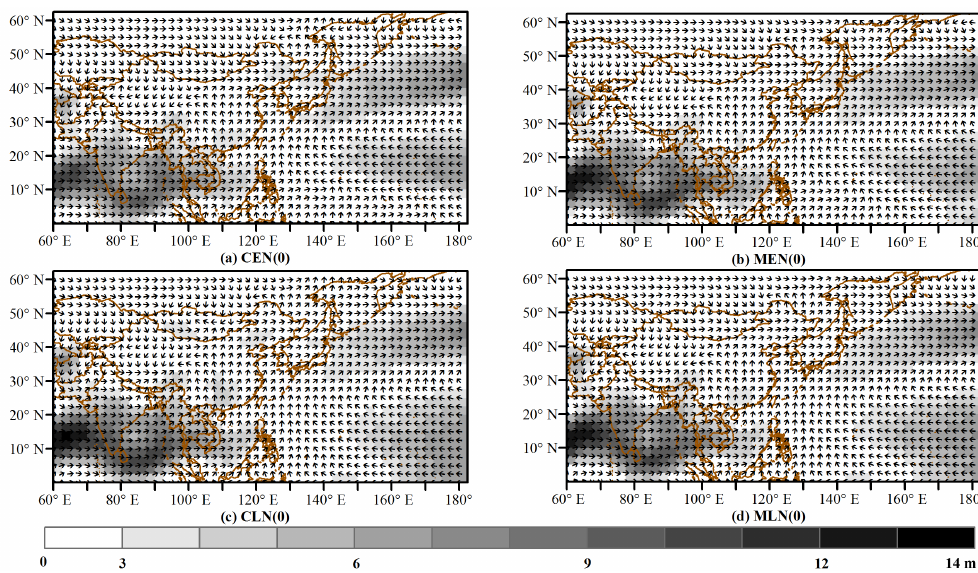
Figure 6. Composites of 850mbar vector wind for mainland China during ENSO and ENSO Modoki developing (0) phases. Arrows show the direction of wind (ms − 1 ); grey shaded areas denote wind speed above 3ms − 1 .